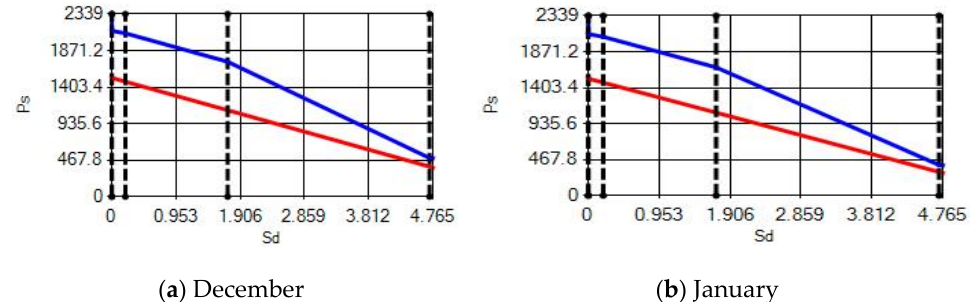
Figure 21. Condensation and evaporation amount chart in the building element of the brick external wall for the 4th zone for ( a ) December and ( b ) January. Characterizing the results obtained from the analysis, no condensation occurred in the building element according to TS 825. The temperature difference between the inner surface and the indoor environment is less than 3 degrees in exterior walls made using AAC, which is in observance with the requirements.